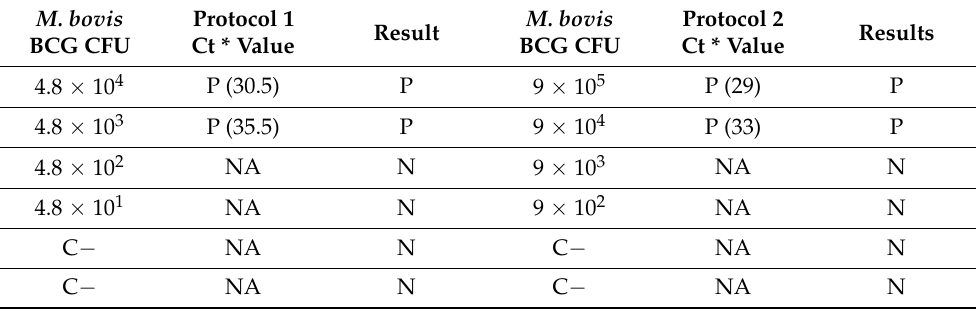
Table 3. IS61160 RT-PCR results, expressed in cycle threshold (Ct), of experimentally contaminated mud samples (C − = negative control; P = positive; N = negative; NA = not amplified). * Ct values were calculated as the average of Ct replicate